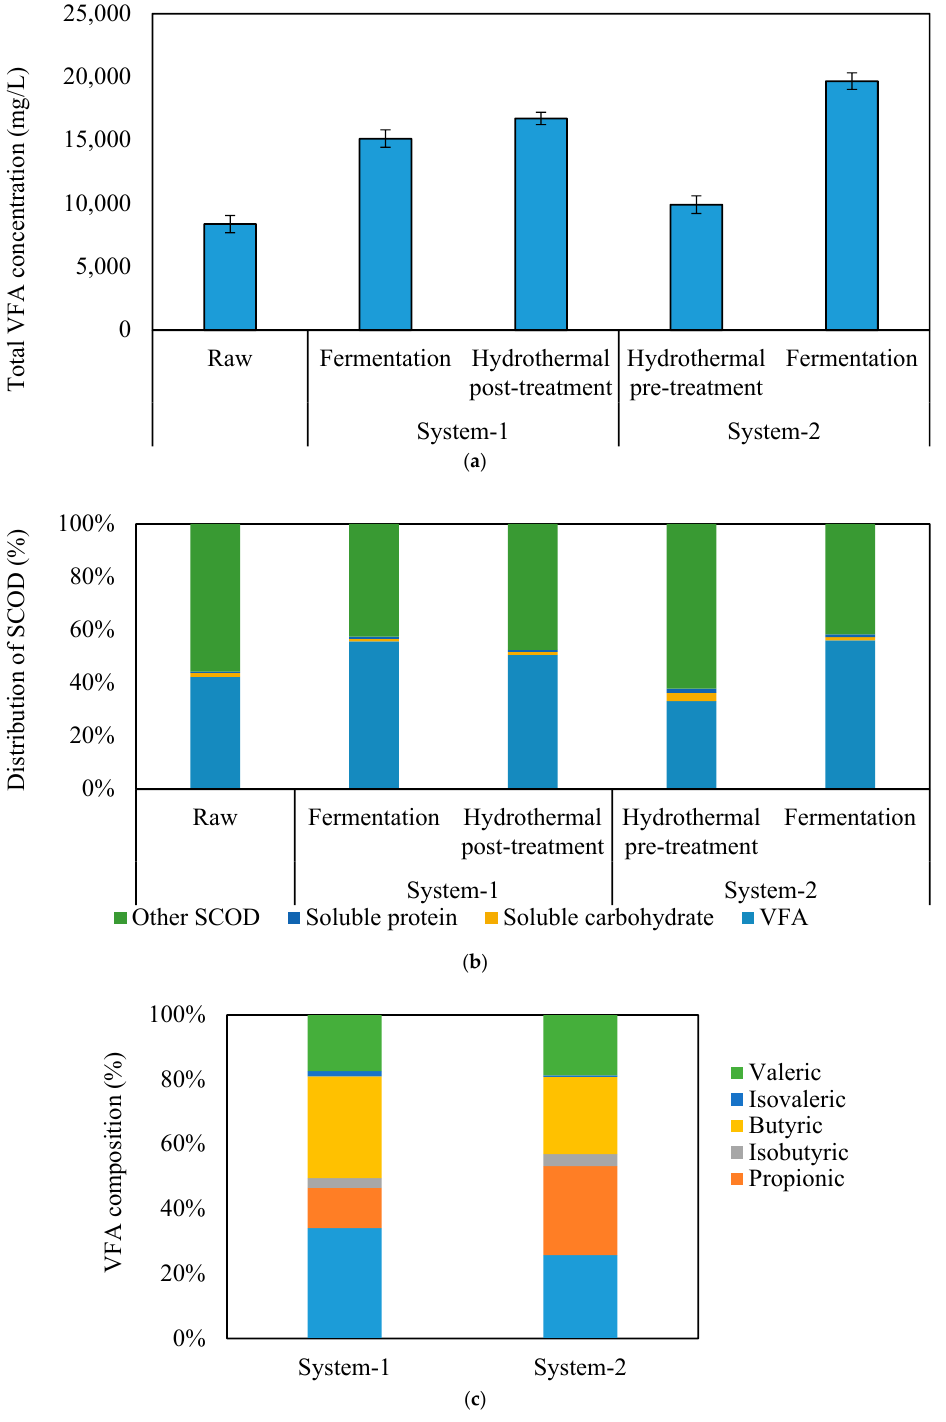
Figure 3. ( a ) The concentration of VFA, ( b ) distribution of SCOD component in raw, treated, and fermented SSO samples, and ( c ) composition of VFA in fermented SSO samples. (SCOD: Soluble Chemical Oxygen Demand, VFA: Volatile Fatty Acids, SSO: Source Separated Organics)